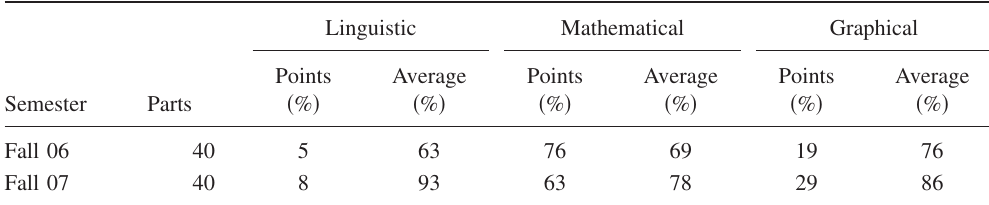
TABLE I. Summary of hourly exams—the tests are broken down into the primary form of communication expected in the answer. The expected communication was determined from the statement of the question; questions asking for a drawing were classified as graphical, questions asking for an explanation without a calculation, linguistic, and questions asking for a calculation, mathematical. The “Points” columns report the percentage of the free-response points allocated to each type of question. The “Score” column reports the average percentage scored on each type of problem. The “Parts” column reports the total number of parts for all free-response problems for each